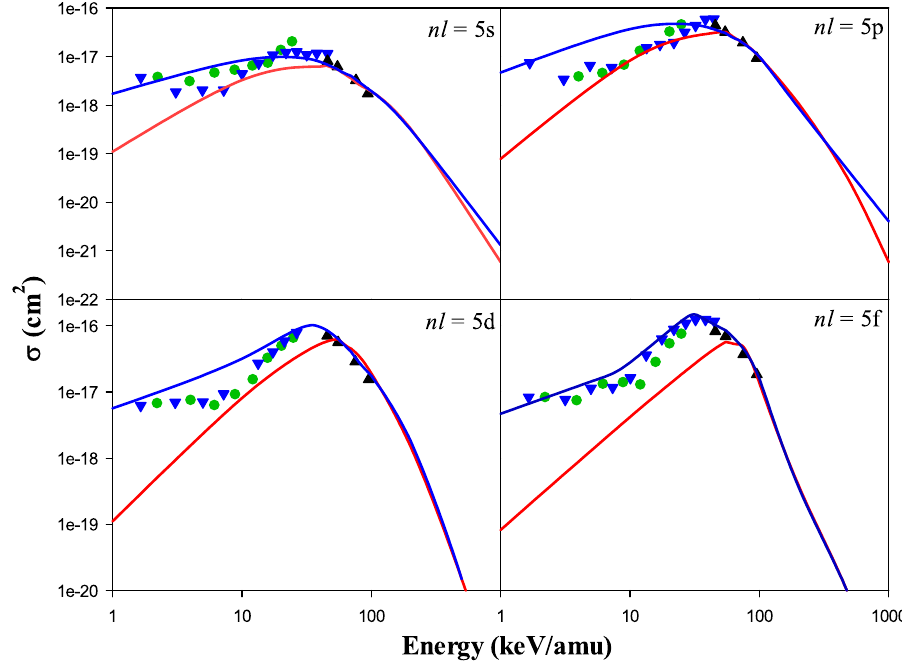
Figure 6. Electron capture cross sections into 5 s , 5 p , 5 d , and 5 f states of the projectile in Be 4+ + H(1 s ) collision, as a function of the impact energy. Solid red line: present CTMC results, solid blue line: present QCTMC results, green circles: QMOCC results of Harel et al. 4 , black triangles: BCCIS results of Das et al. 14 , blue inverse triangles: OEDM results of Errea et al. 13 .